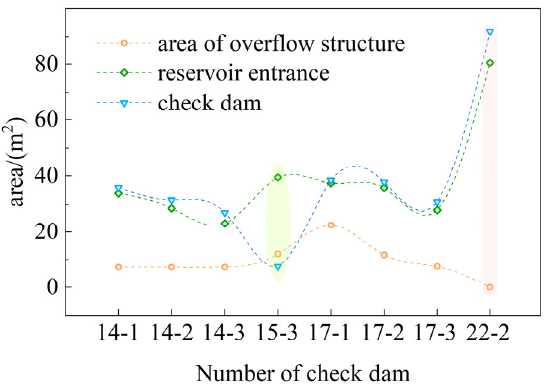
Figure 8. Comparative analysis of overflow area of typical check dam.